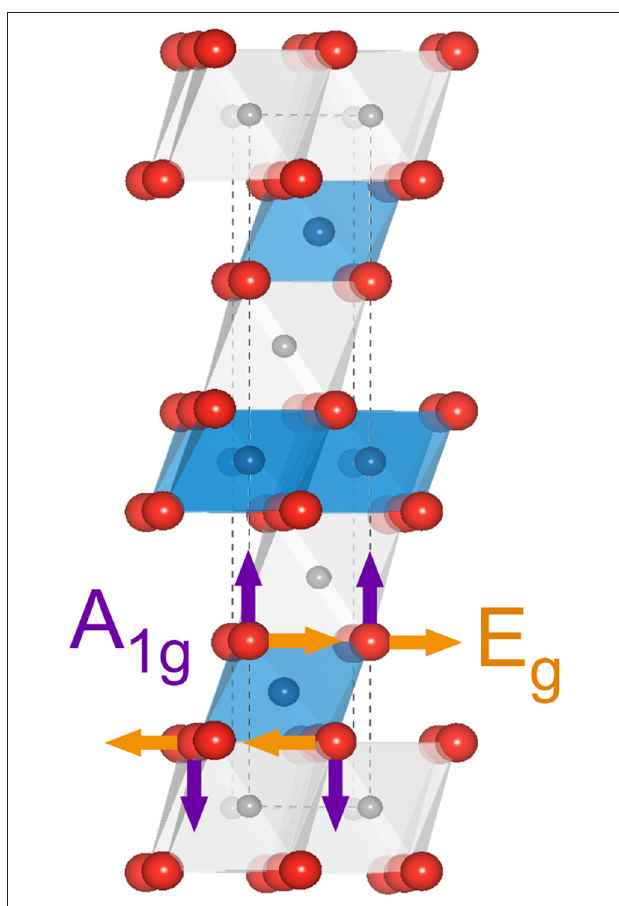
FIGURE 3 | Schematic representation of the LiMO 2 unit cell. The gray, blue and red spheres represent Li, M and O atoms, respectively. The atomic displacements from E g and A 1g vibrational modes are shown in orange and purple arrows,